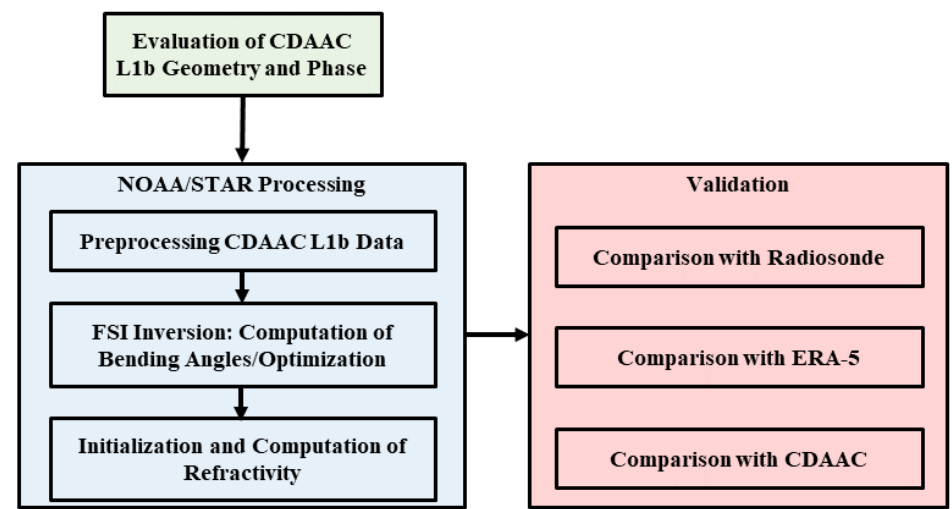
Figure 1. An outline of the NOAA/STAR data processing and validation scheme.